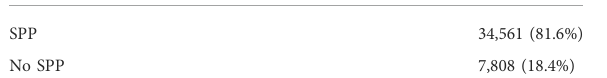
TABLE 2 SPP implementation in documents.